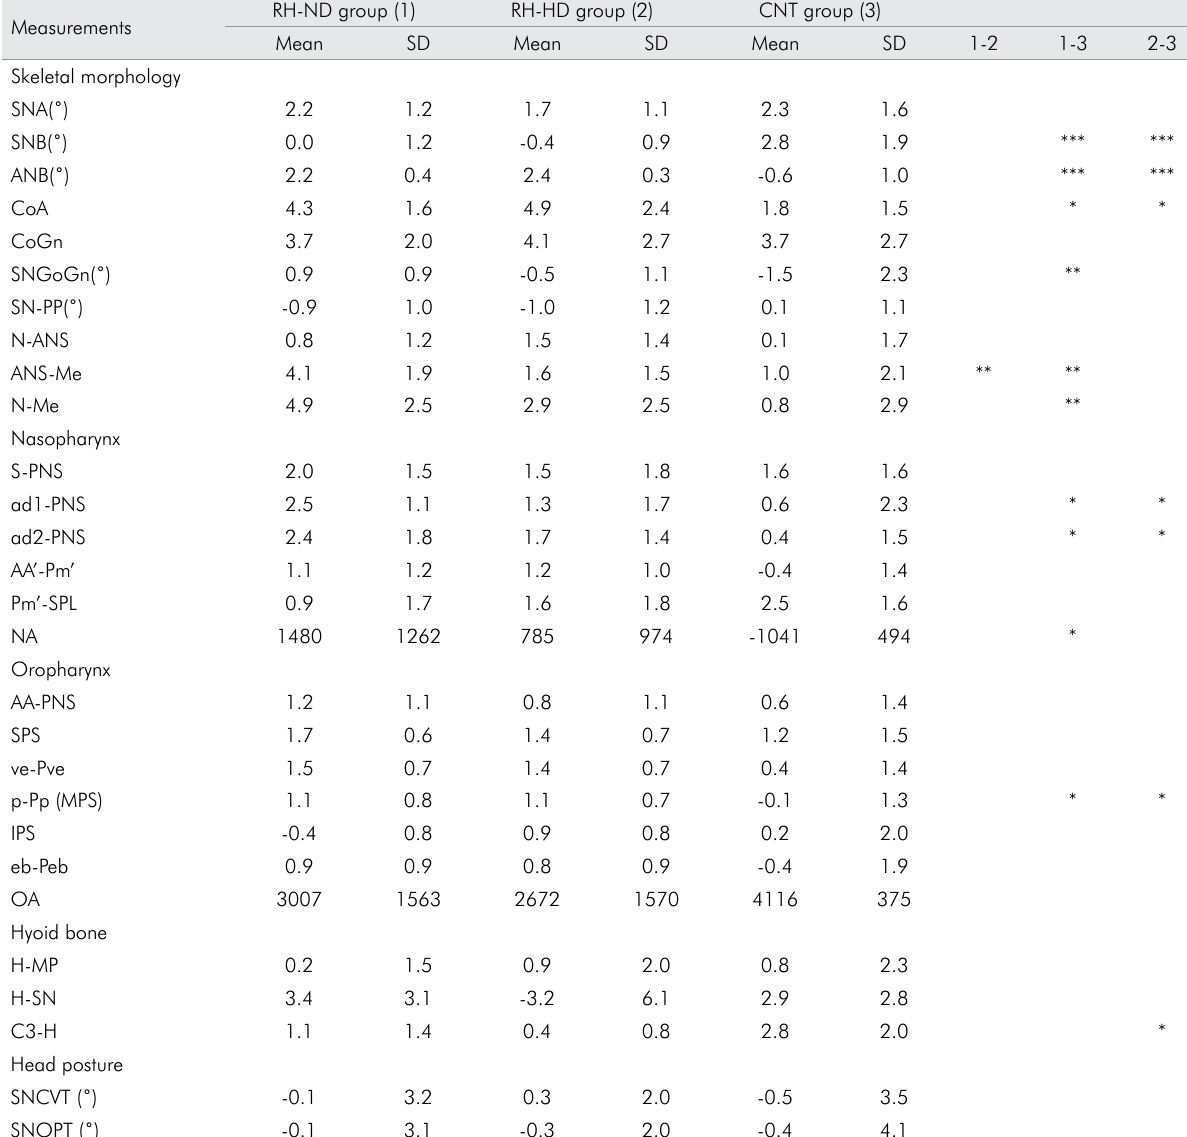
Table 2. Comparison of the changes between treatment and control